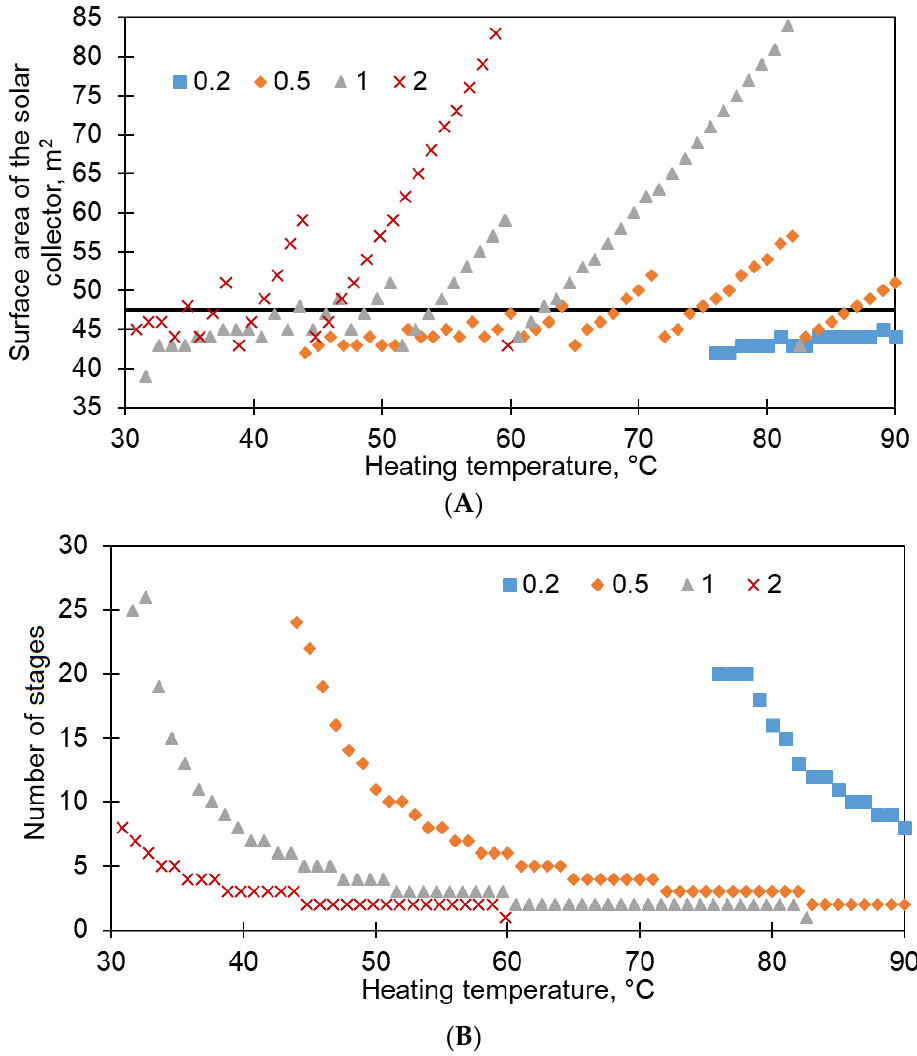
Figure 8. The dependence of the surface area of the solar collectors ( A ) and the number of stages of evaporation modules ( B ) depending on the heating temperature of the solution required to ensure a capacity of at least 12 L/m 2 h for various variants of the evaporator surface area (as well as the area of the condenser). The dotted line marks the average median of the surface area of the solar collector. According to the results, there are such configurations of evaporative modules that allow, while maintaining the system performance, to maintain low heating temperatures of both the solution itself and the heat accumulator tank. At the same time, with an increase in the surface area of the evaporation stage, the required number of stages obviously decreases, which will avoid the construction of bulky